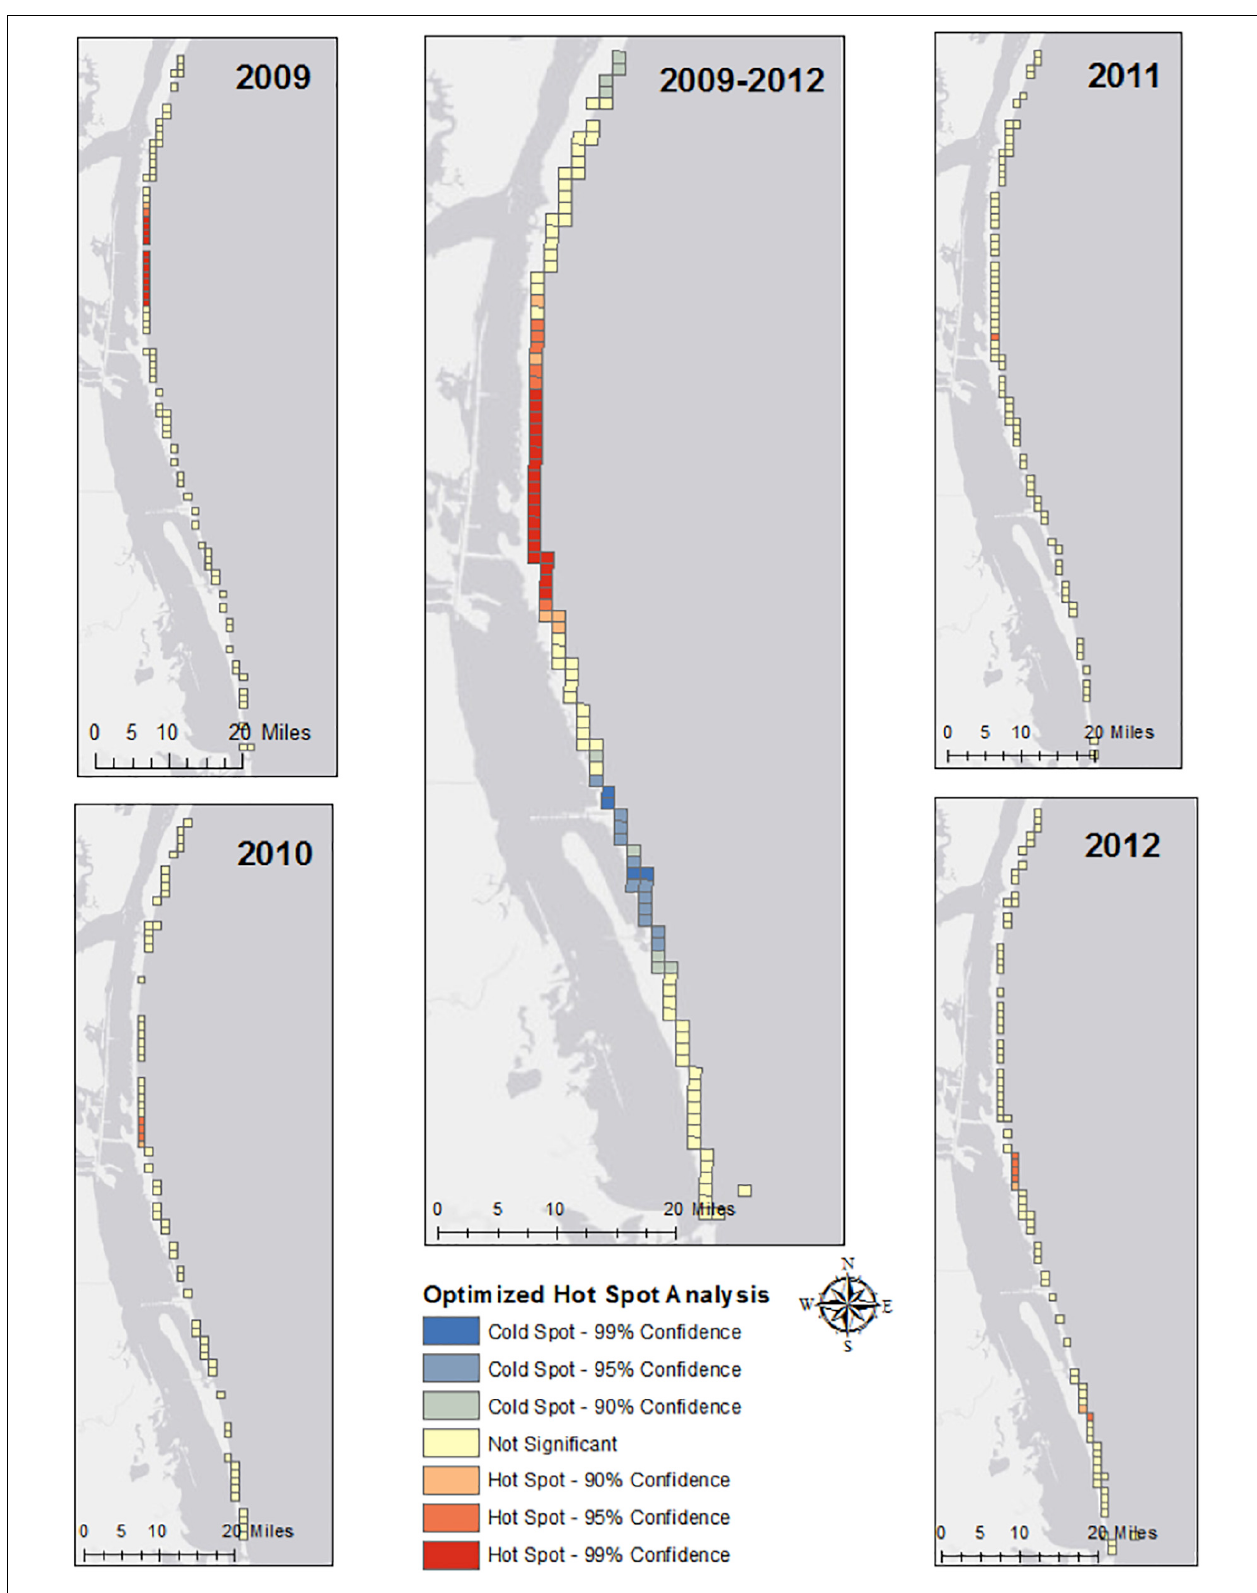
FIGURE 2 | Statistically significant hot spots and cold spots for each year of data produced using the Optimized Hot Spot Analysis tool in ArcGIS.